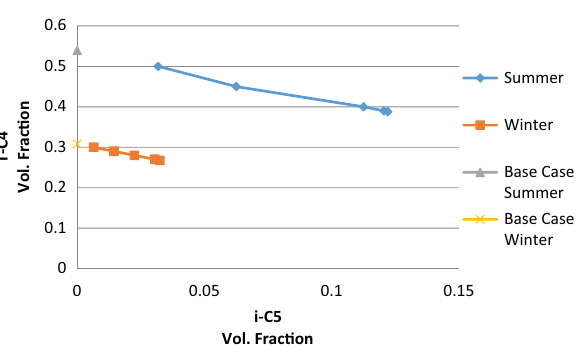
Fig. 8 Limitation of adding i-C5 to LPG